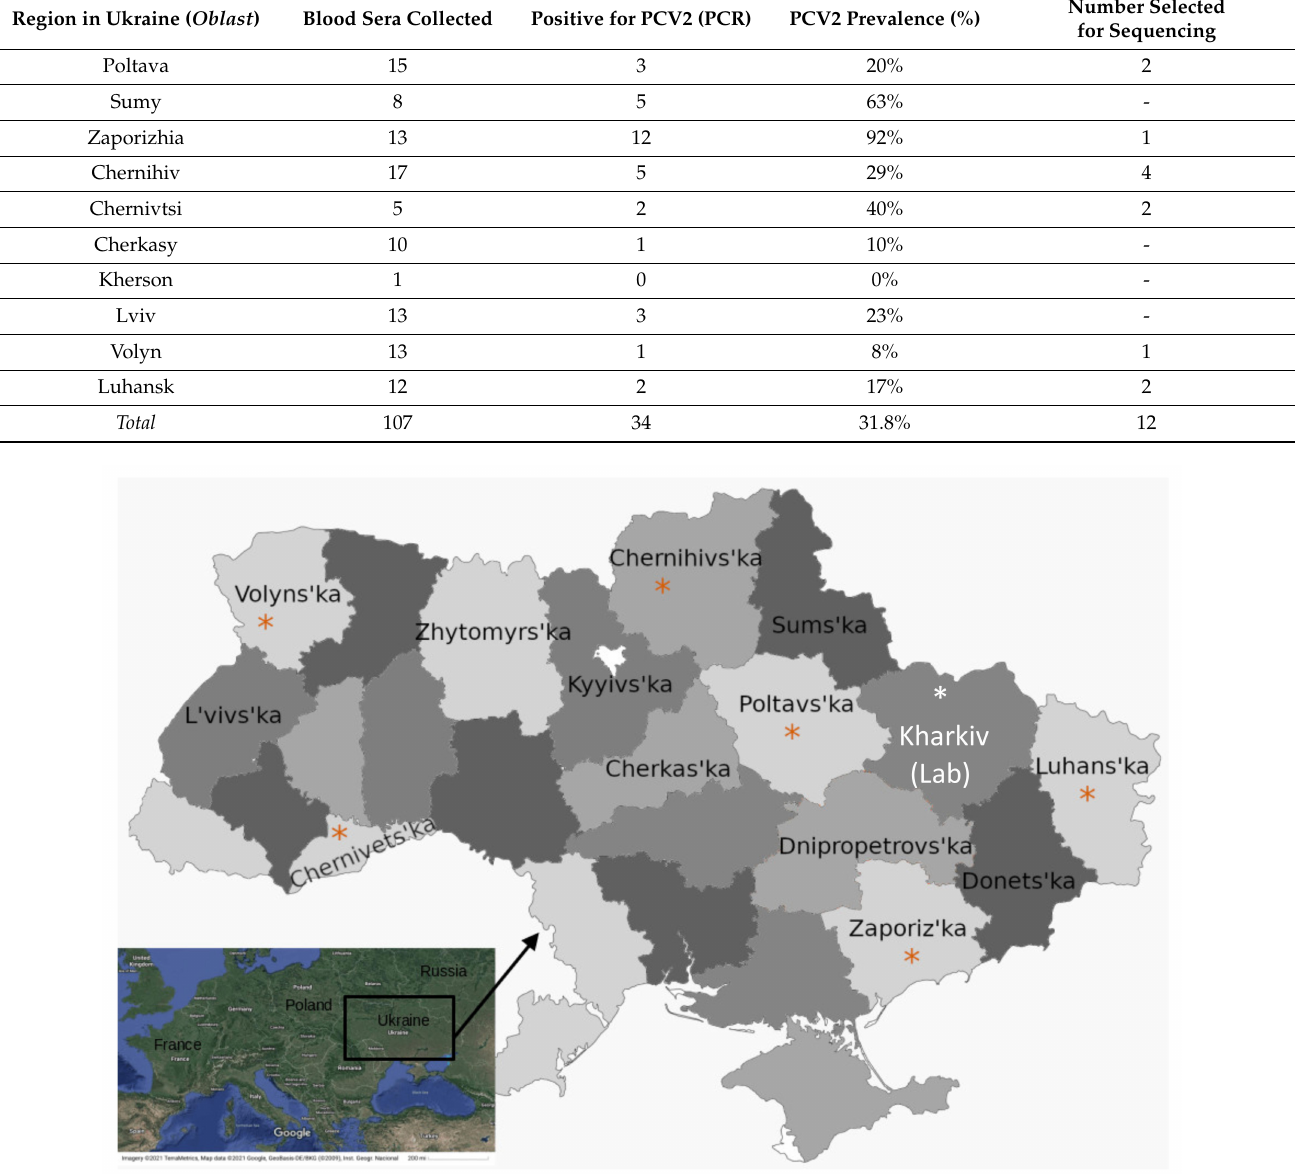
Figure 1. Sampling for PCV2 in Ukraine in wild boar and domestic pigs. Map of Ukraine showing the oblasts (provinces) where wild boar blood serum samples were collected opportunistically over the November–December 2012 winter hunting season (red asterisks). Domestic pig liver samples were collected from a commercial market near Karhkiv in 2019, at the site of the NSC IECVM veterinary lab (white asterisk). Other PCV2 sequences downloaded from GenBank were from the named oblasts on the